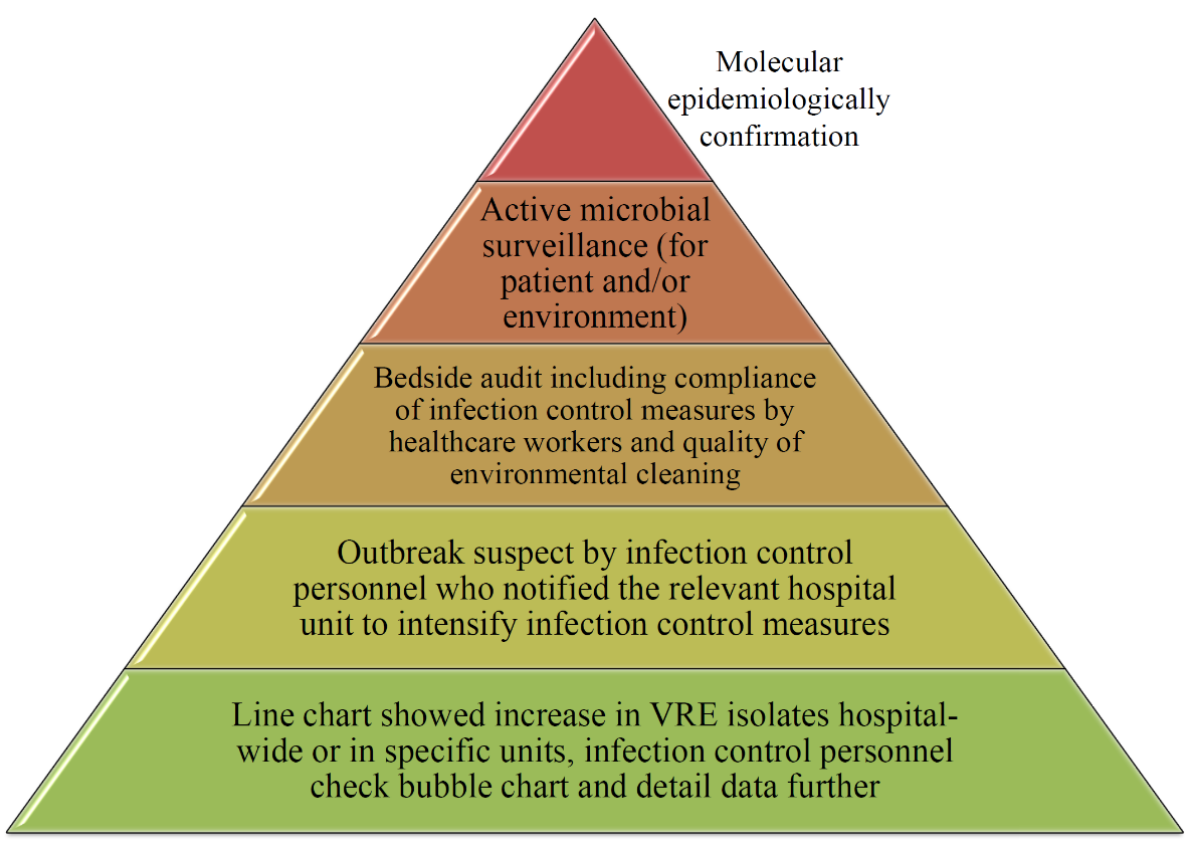
Figure 10. The pyramid of vancomycin-resistant Enterococcus outbreaks identified, investigated, and confirmed, showing the concept of the integrated Web-based surveillance and outbreak detection system and infection control personnel